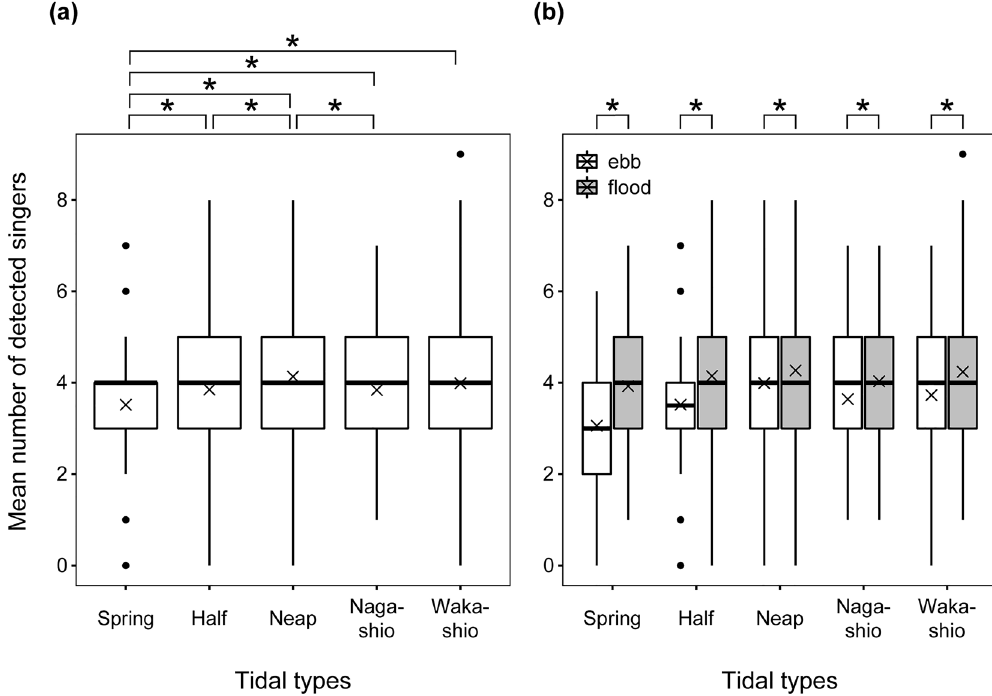
Figure 5. Differences in the mean number of detected singers: ( a ) for each tidal type and ( b ) between during the ebb and flood periods for each tidal type. The lines in the middle of boxes represent the median, and the cross marks show the mean. The bottom and top of the boxes indicate the 25th and 75th percentiles. Whiskers represent 1.5 times the interquartile range, and dots are outside of this range. Asterisks (*) indicate statistically significant differences between the groups (Steel–Dwass test, p < 0.05 in [ a ]; Mann–Whitney U test, p < 0.05 in [ b ]).